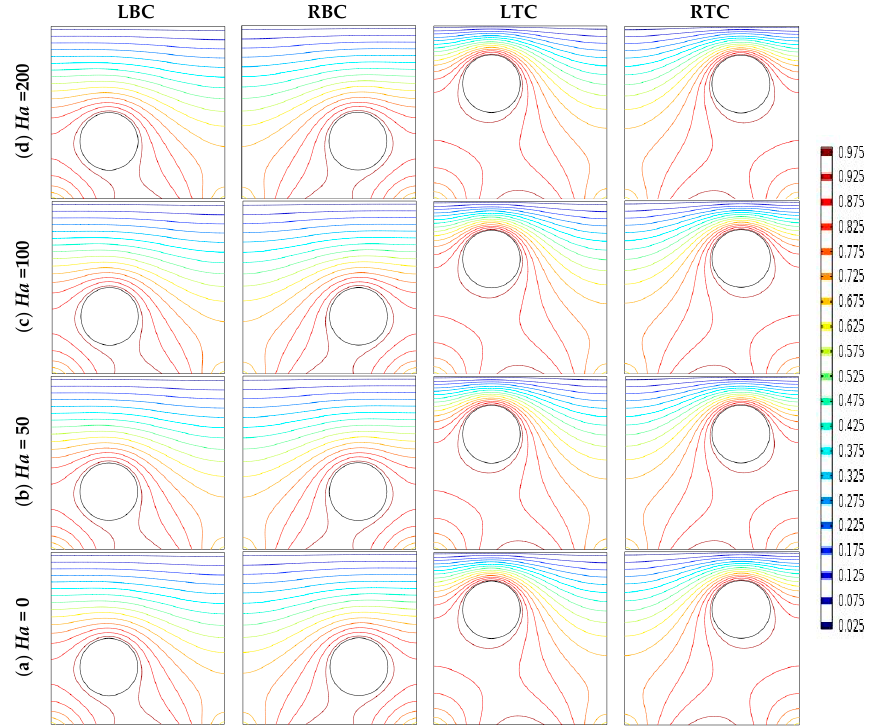
Figure 5. Streamlines for different orientations of heated cylinders for Ha = 0–200 , Ra = 10 3 and Pr = 0.71 .